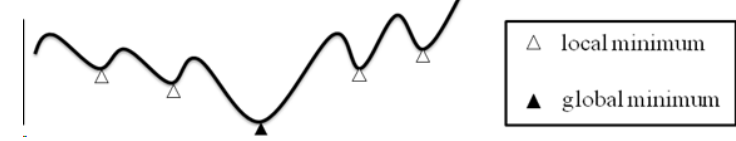
Figure 6. Solution of a general non-linear programming